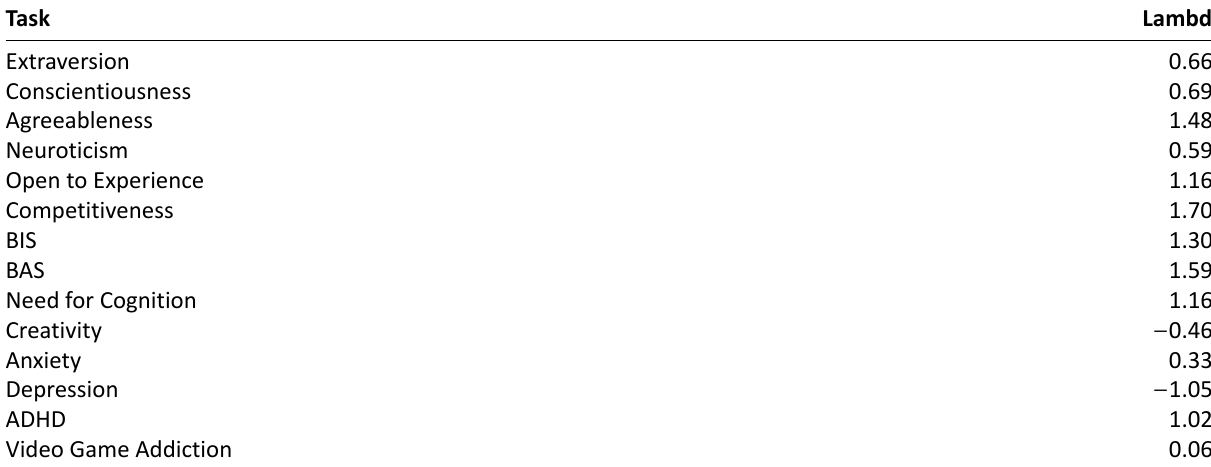
Table A4. Box-cox transformations utilized to make data normally